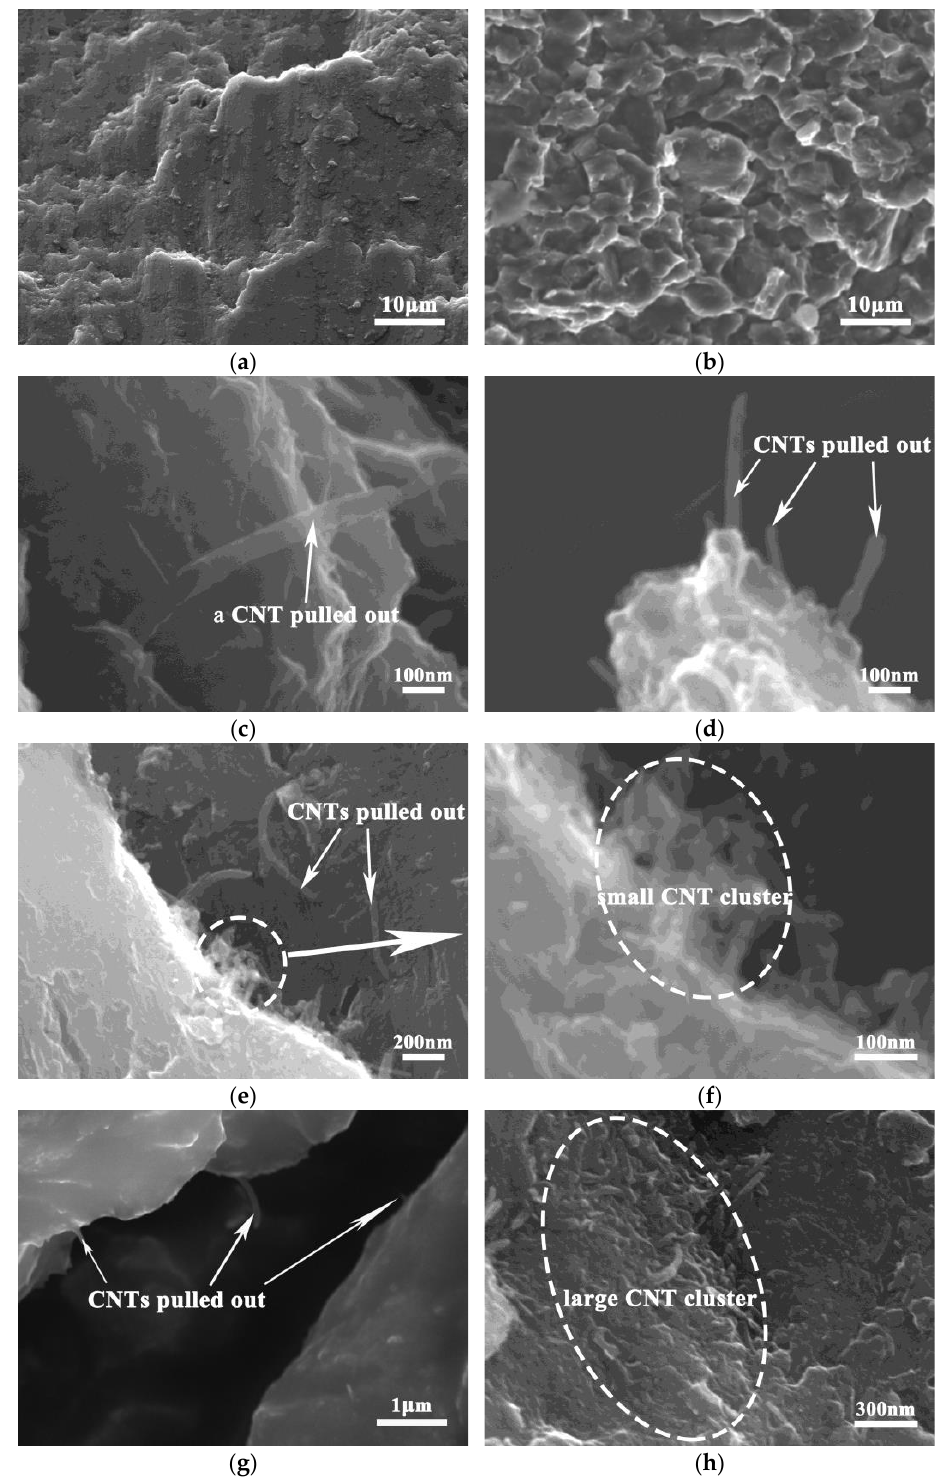
Figure 8. SEM images of the fracture morphologies in CNT/Mg composites with different contents of CNTs: ( a ) pure Mg; ( b ) CNT/Mg composites; ( c ) 0.5 vol.%; ( d ) 1 vol.%; ( e , f ) 1.5 vol.%; ( g , h ) 2.5 vol.%.